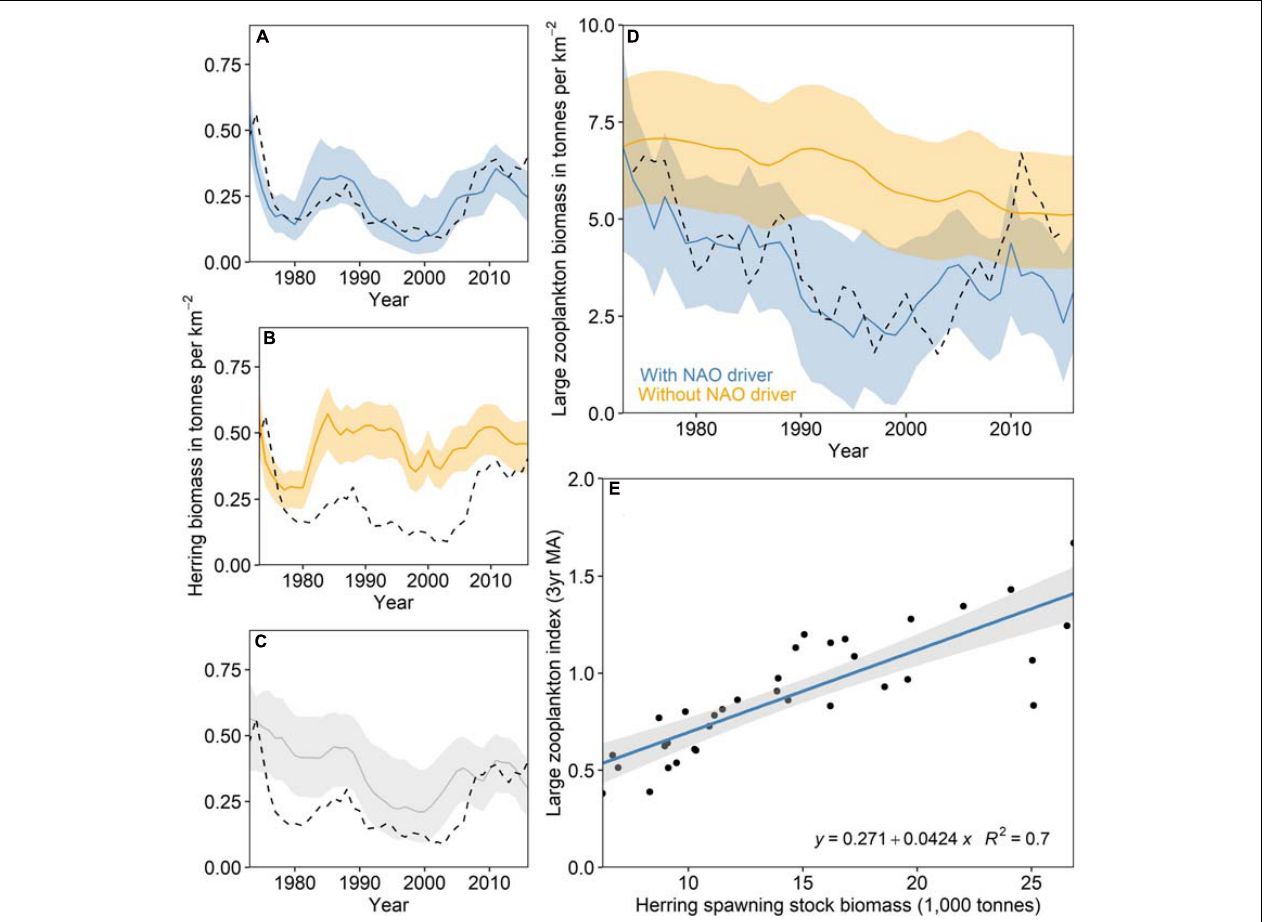
FIGURE 4 | Relationship between large zooplankton biomass and Irish Sea herring production. The key drivers of Irish Sea herring biomass in the Irish Sea EwE model are: (i) fishing pressure, and (ii) the biomass trend of large zooplankton. (A) The solid line indicates the model simulation, the shaded area is the 95% uncertainty bounds based on input data uncertainty, and the dashed line is the single-stock assessment. (B) Agreement between EwE simulations and stock assessment results decreased when large zooplankton biomass was not well replicated (i.e. the NAOw is not used as a driver of zooplankton mortality) and (C) fishing mortality is not accounted for. (D) Large zooplankton biomass simulations are improved when production is driven by the North Atlantic Oscillation (dashed line is the index of large zooplankton ( > 2 mm) from the Continuous Plankton Recorder (CPR) with a three-year moving average). (E) Returning to the ‘raw’ data, a positive linear relationship is identified between herring SSB and CPR large zooplankton index with a 3-year moving